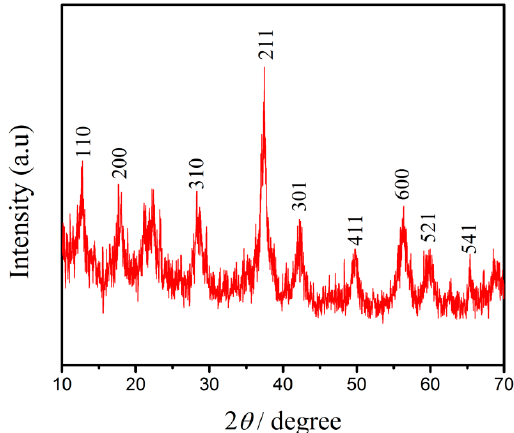
Figure 2. XRD pattern of MnO 2 NRs.